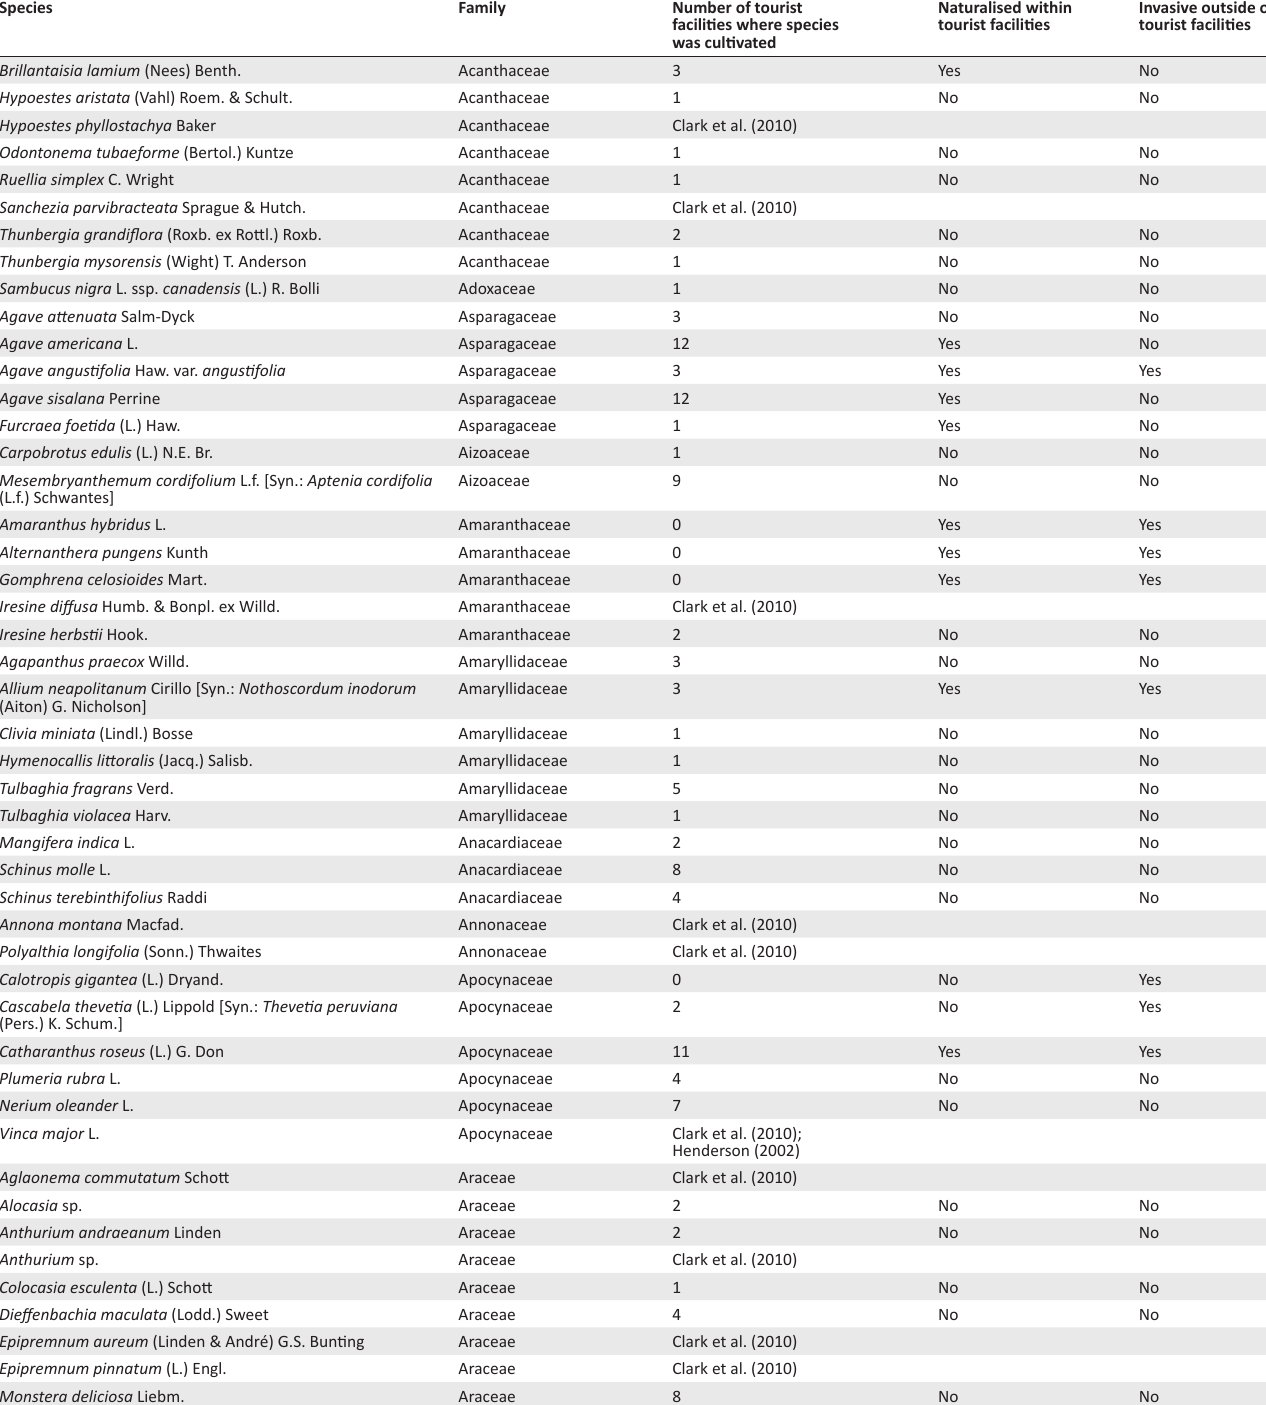
TABLE 1: Alien plant species, including some native plant species which may be growing outside of their natural range, recorded in the Serengeti-Mara ecosystem and immediate surrounds (excluding vegetable crops and grains).